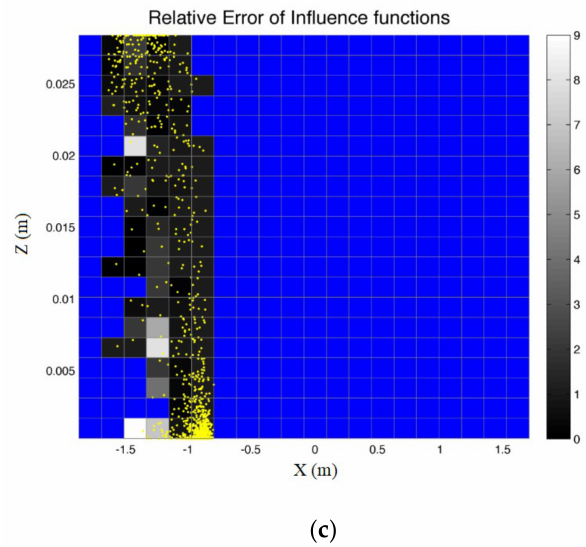
Figure 11. ( a ) Backward influence functions; ( b ) forward influence functions; ( c ) the relative error between backward and forward influence functions.